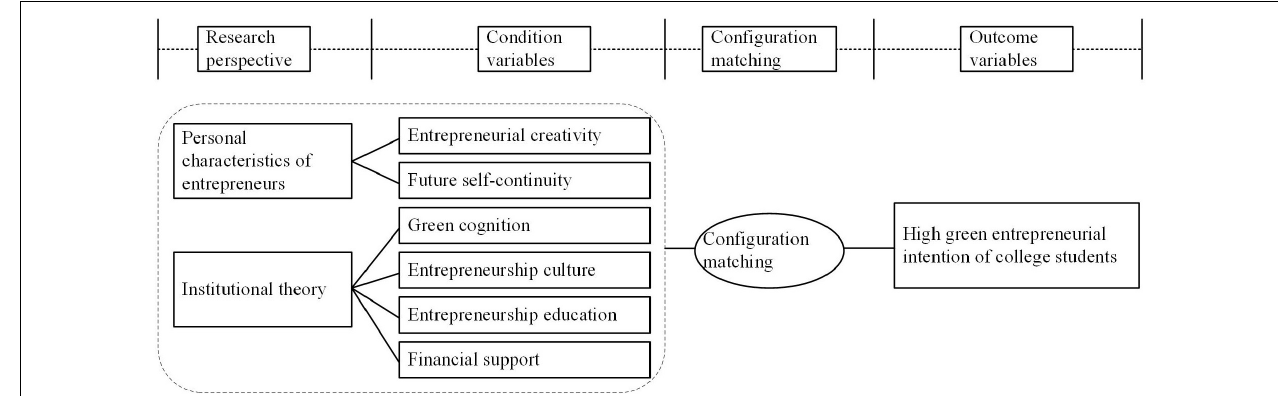
FIGURE 1 | Research